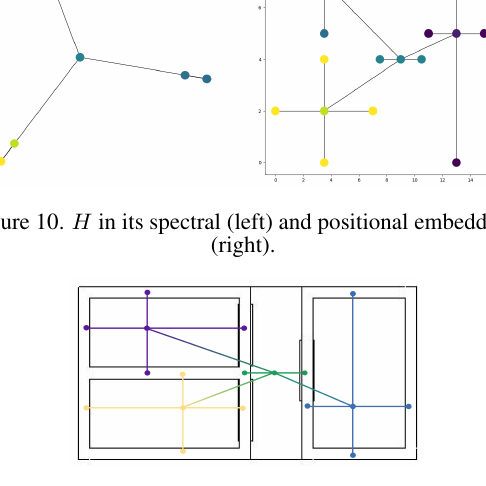
Figure 11. Conceptual representation of H .